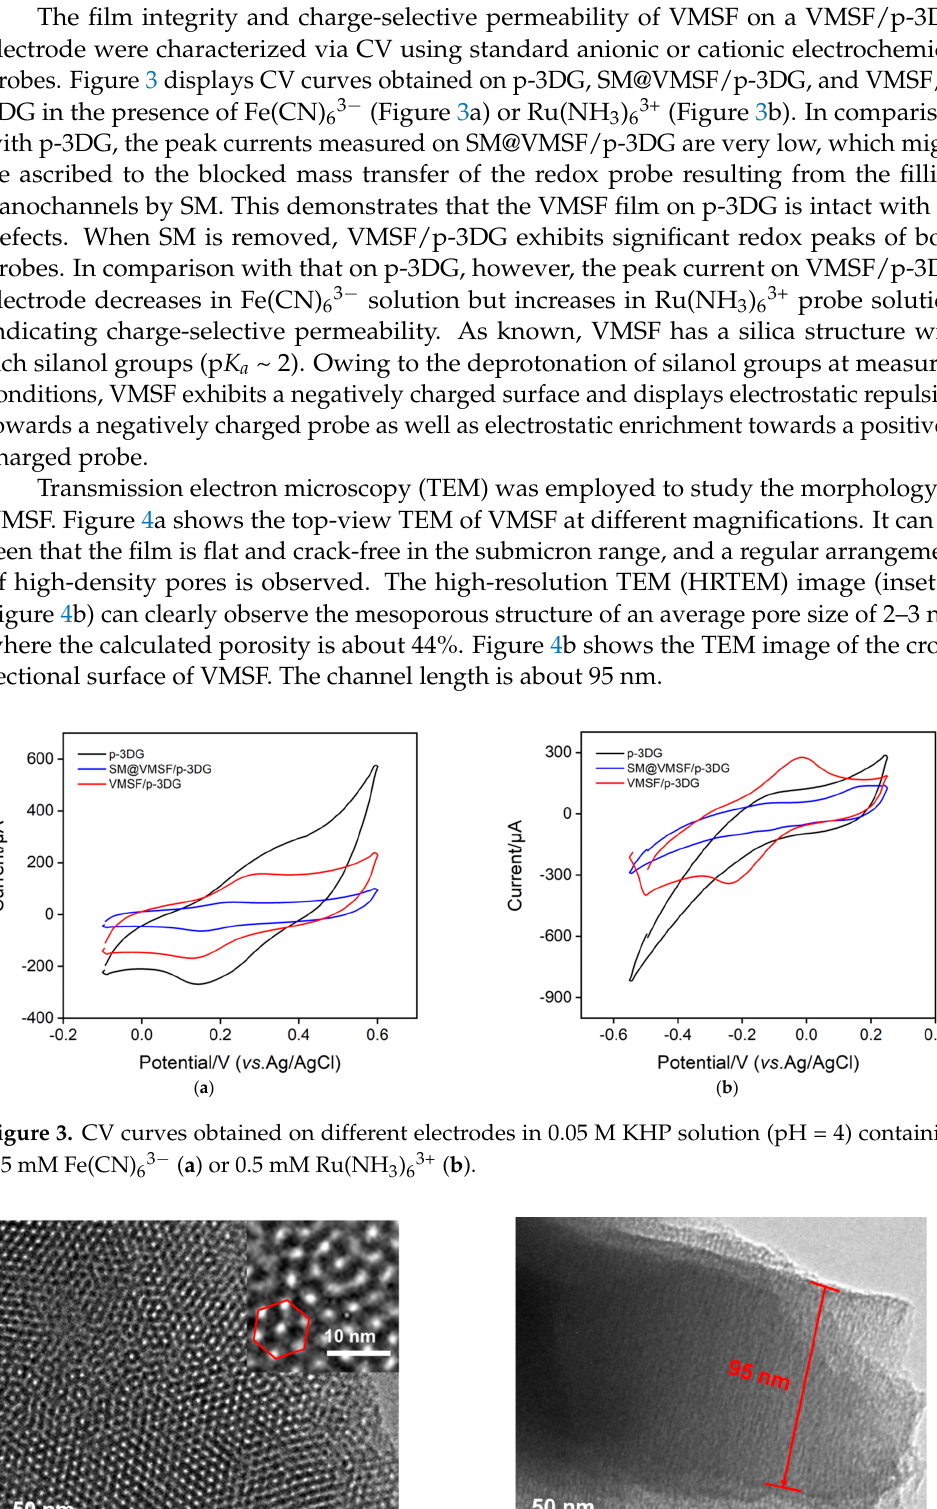
Figure 2. ( a ) CV responses obtained at 3DG and p-3DG electrodes in 0.5 mM Fe(CN) 63 − (in 0.1 M KCl medium). ( b ) Contact angle photos of 3DG and p-3DG. ( c , d ) High-resolution C 1 s XPS spectra of 3DG ( c ) and p-3DG ( d ). ( e , f ) SEM images of ( e ) 3DG and ( f ) VMSF/p-3DG.